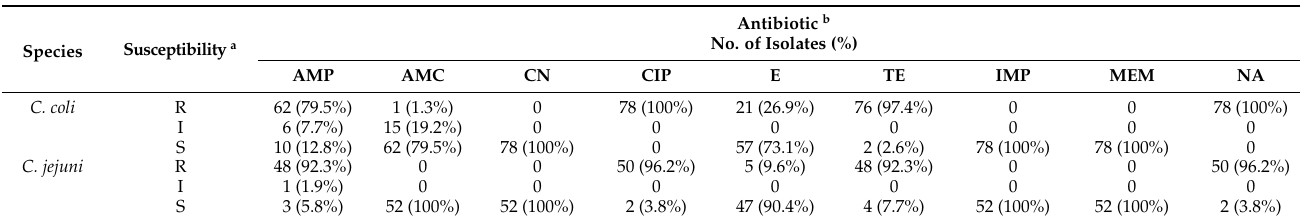
Table 3. Overall distribution of antibiotic susceptibility of Campylobacter by species.